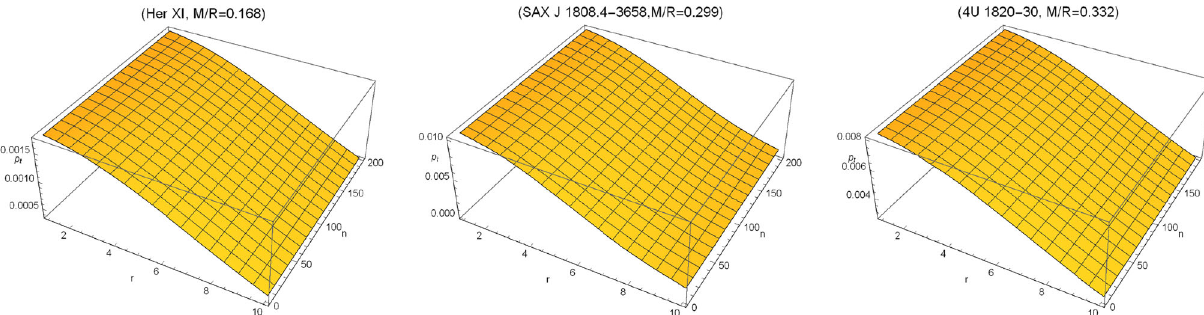
Fig. 5 Behavior of transverse pressure p t with radial coordinate r (km) and model parameter n